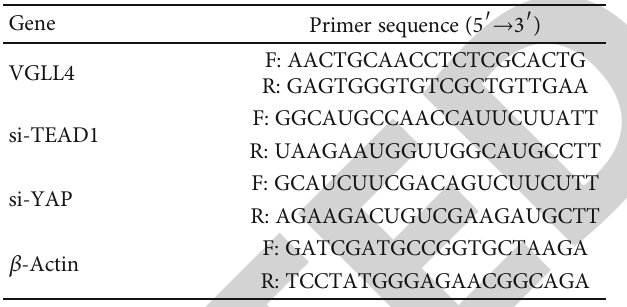
Table 1: Primer sequences used in reverse transcription quantitative polymerase chain